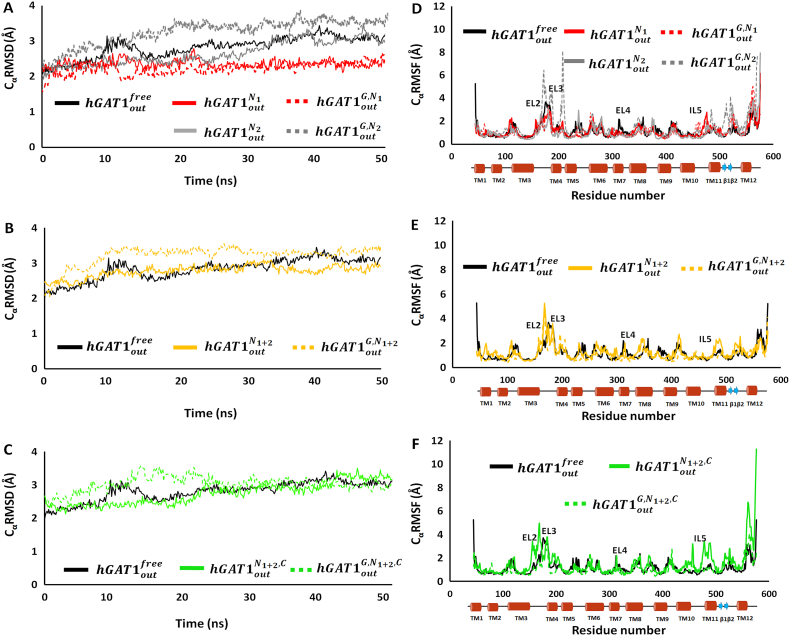
(A-C) CαRMSD and (D-F) CαRMSF plots for the apo (black), mono-sodium (red and grey), di-sodium (yellow) and the fully loaded (green) state of hGAT1 with (dotted line) and without (solid line) GABA. The apo state hGAT1outfree (black), serves as the reference state for the simulation. Overall GABA binding leads to destabilization of the hGAT1outG, N2 and hGAT1outG, N1+2 complexes with increase conformational flexibility in the EL2 region between TM3 and TM4 of hGAT1.